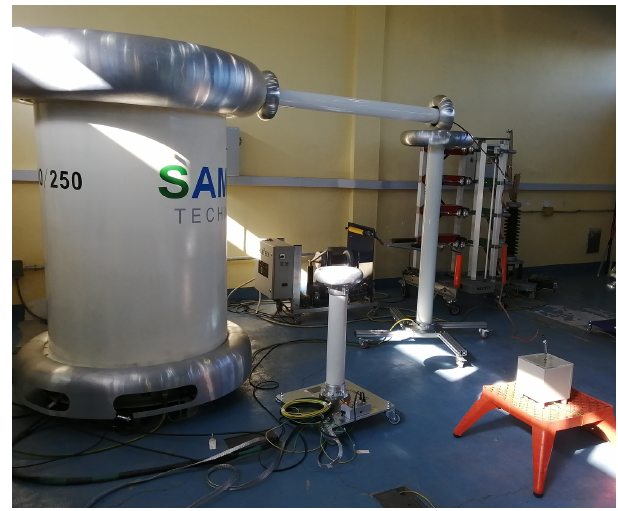
Figure 6. Step-up transformer and test cell for the AC dielectric strength tests.